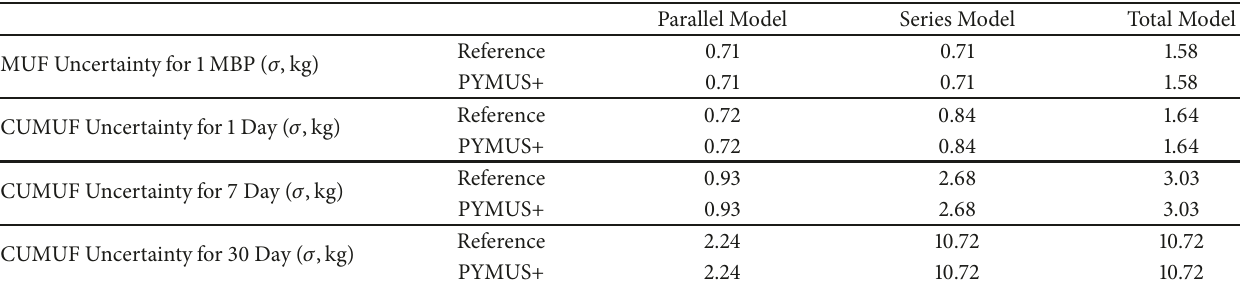
Table 2: Comparison between reference result and simulation result in intercomparative study